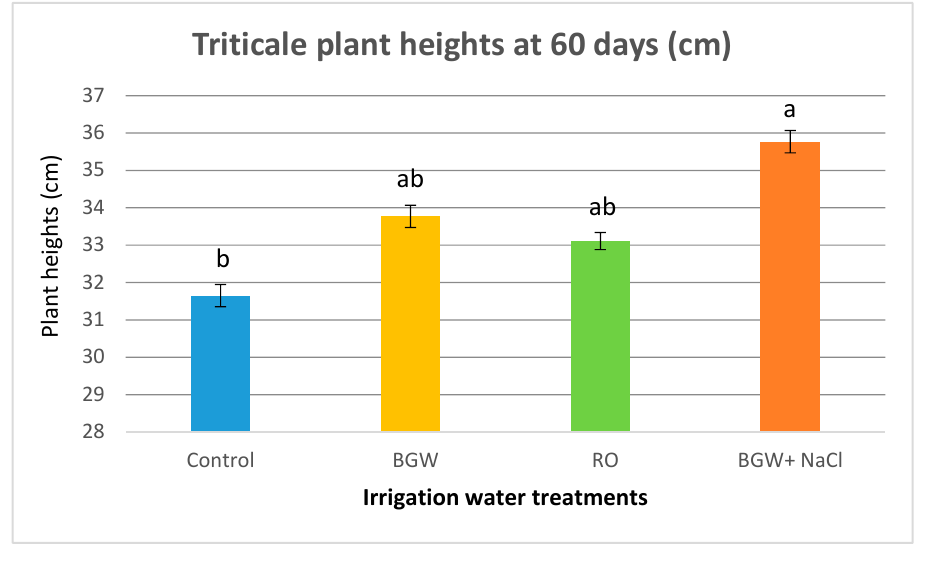
Figure 4. Plant heights were measured at 30, 60, and 90 days during the entire plant growth period, but the above figure shows the mid-growth stage (at 60 days). Means within species sharing the same letter are not significant at α ≤ 0.05. Each observation is the mean ± SEs of four replications. The ECs of the saline treatments were control (0.7 dSm − 1 ), BGW (4 dSm − 1 ), RO (8 dSm − 1 ), and BGW + NaCl (8 dSm − 1 ).